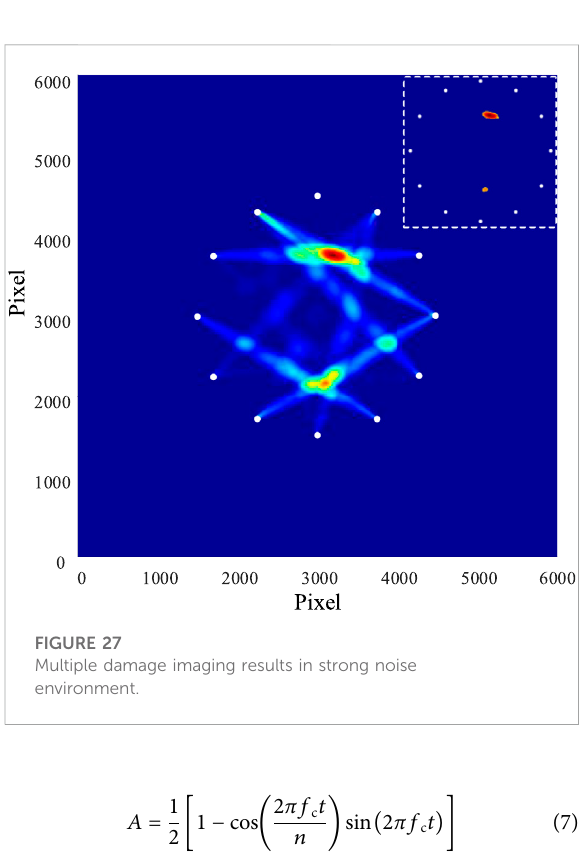
FIGURE 27 Multiple damage imaging results in strong noise